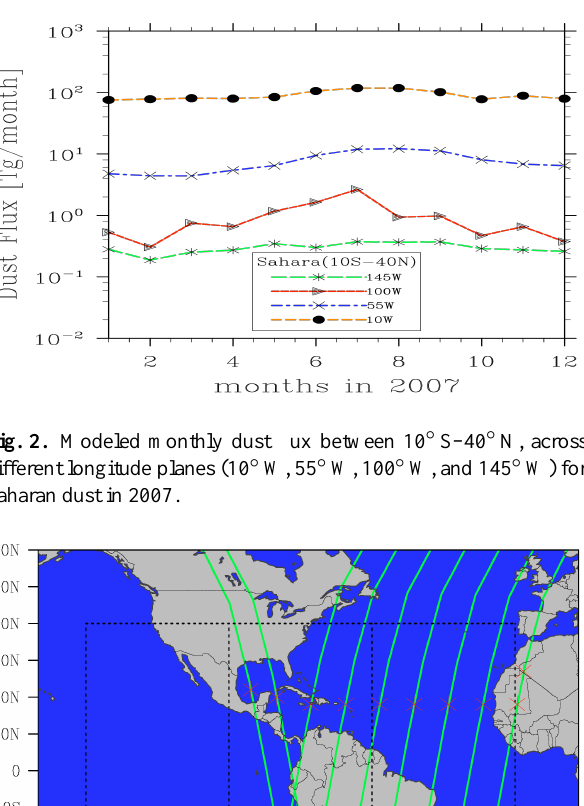
Fig. 1. The daily-averaged and column-integrated spectral optical depth (500nm) at Osaka in May 2007 (top) and at Capo Verde in July 2007 (bottom) both from our model and from AERONET data.